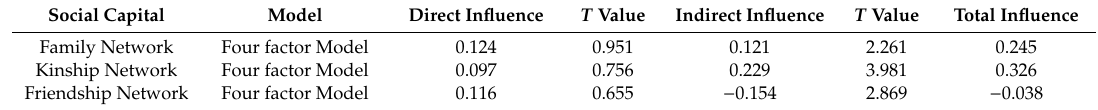
Table 4. Influence with consideration of socioeconomic